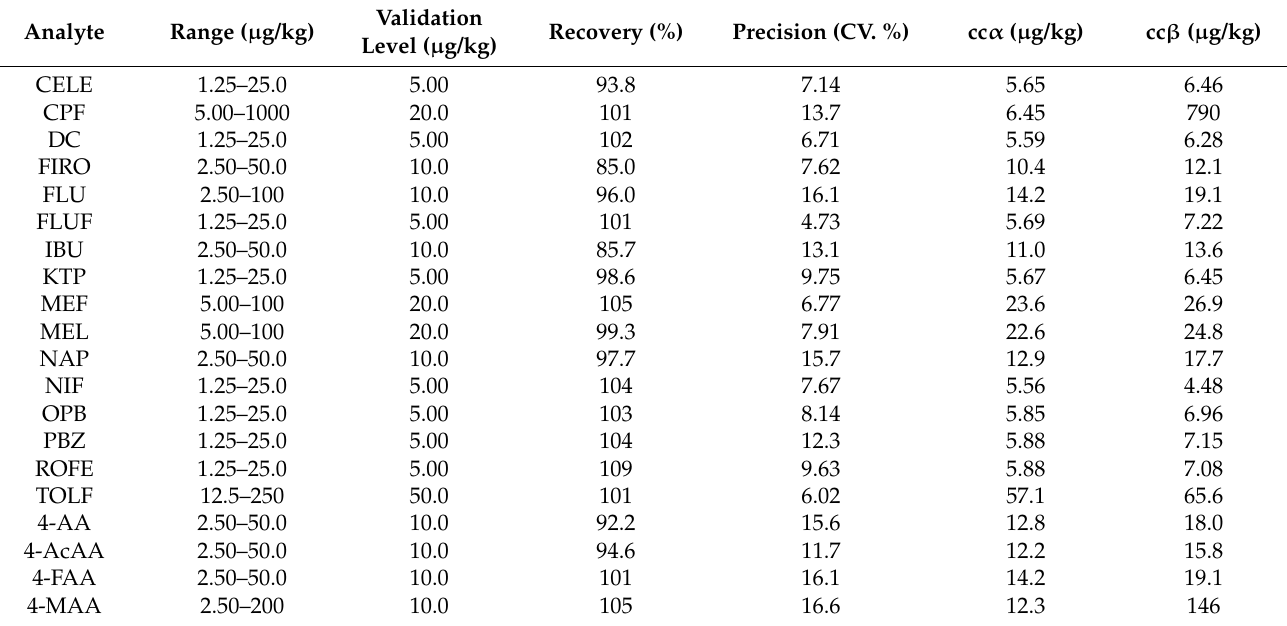
Table 3. Validation data for analyses of muscle